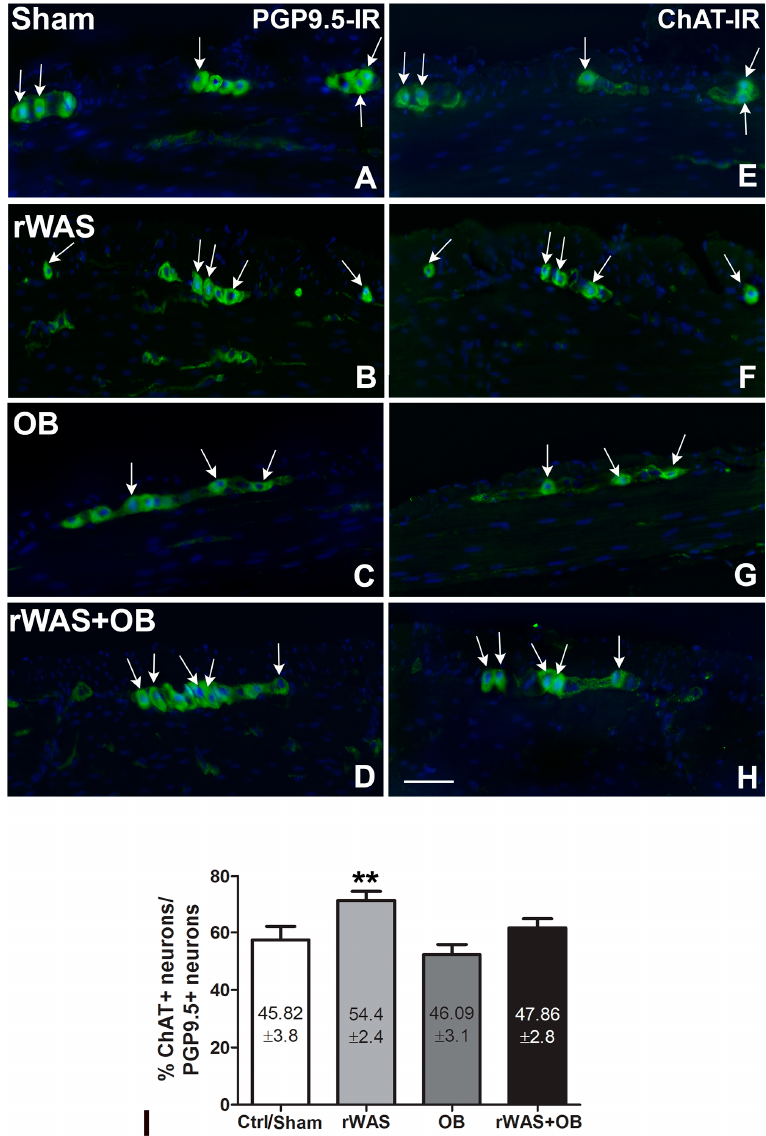
Figure 4. Protein Gene Product 9.5 (PGP9.5) and Choline Acetyl-Transferasi (ChAT)-immunoreactive (IR) myenteric neurons. PGP9.5 ( A – D ) and ChAT ( E – H ) labeling (green) in the myenteric neurons of Sham ( A , E ), rWAS ( B , F ), OB ( C , G ), and rWAS+OB ( D , H ) rat distal colon. Hoechst 33342 labeled the nuclei (blue). The arrows indicate the neurons that express both PGP9.5 and ChAT. Bar = 50 µm. Quantitative analysis of the percentage (%) of ChAT-IR neurons respect to the total PGP9.5-IR neurons and of the total number of ChAT-IR neurons. ( I ). The columns express the %. The number of ChAT-IR neurons is reported inside the columns. Both parameters showed a significant increase in the rWAS compared with all the other groups. Only the labelled neurons containing the nucleus were included in the statistical analysis. One-way ANOVA followed by Newman–Keuls post-test, ** p < 0.005. (n = 5).